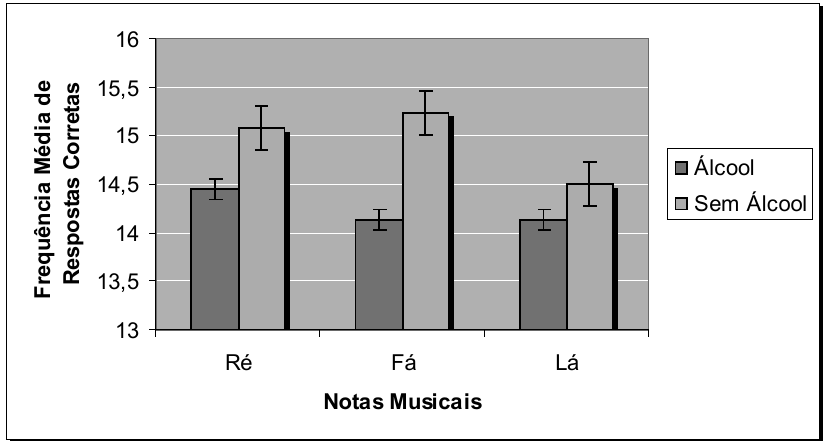
Figura 2. Discriminação das notas musicais pelos voluntários ( n =40) nas condições ex- perimental (álcool) e controle (sem álcool). Os resultados foram signi fi cantes para as três frequências sonoras